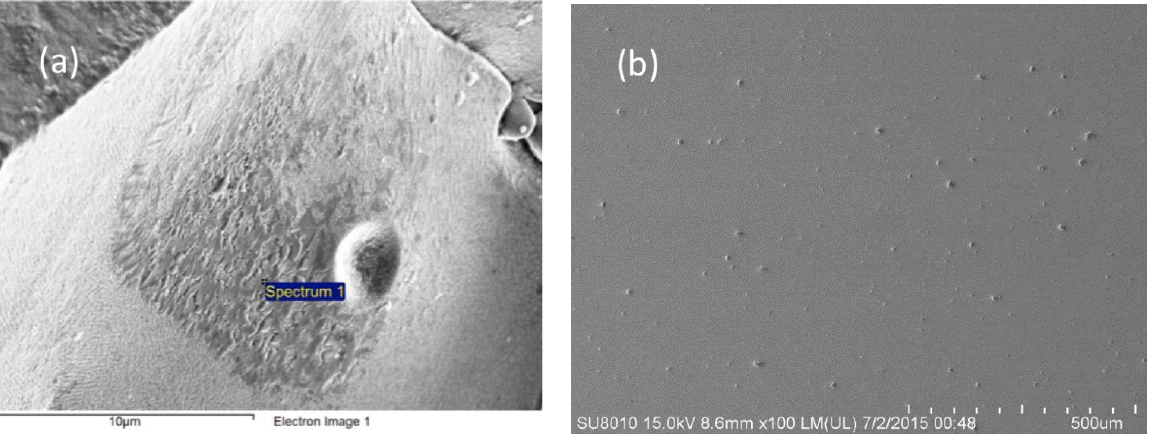
Figure 3. ( a ) Film-like precipitates on the inter-granular facets after 1220 °C tensile test; ( b ) as-heat treated microstructure. Table 2. Chemical composition of Ti-rich precipitates via SEM-EDAX analysis in wt. %. Element Fe Ni Cr Ti Mn wt.